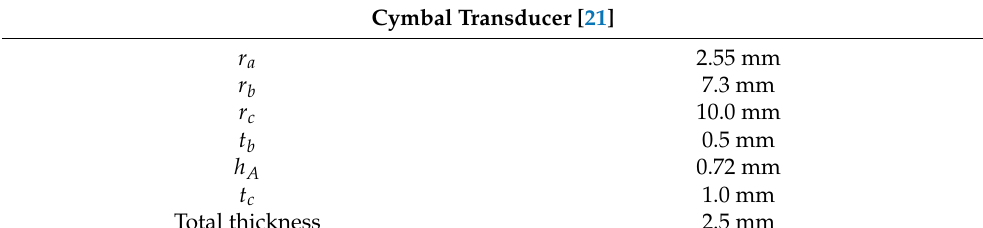
Table 1. Parameters of reference cymbal transducer.